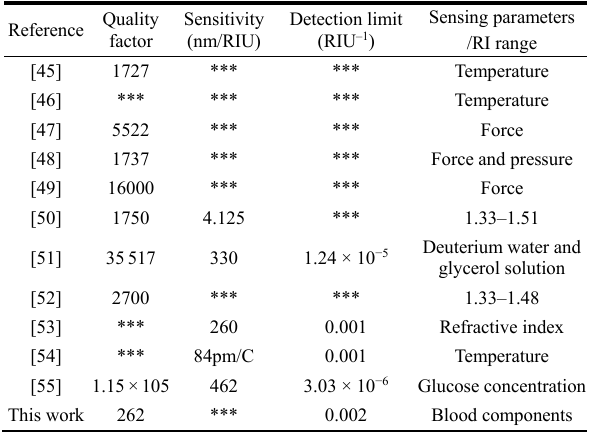
Fig. 7 Refractive index versus resonant wavelength. Table 3 Comparison of quality factor, sensitivity, detection limit and sensing parameters of the proposed sensor with reported